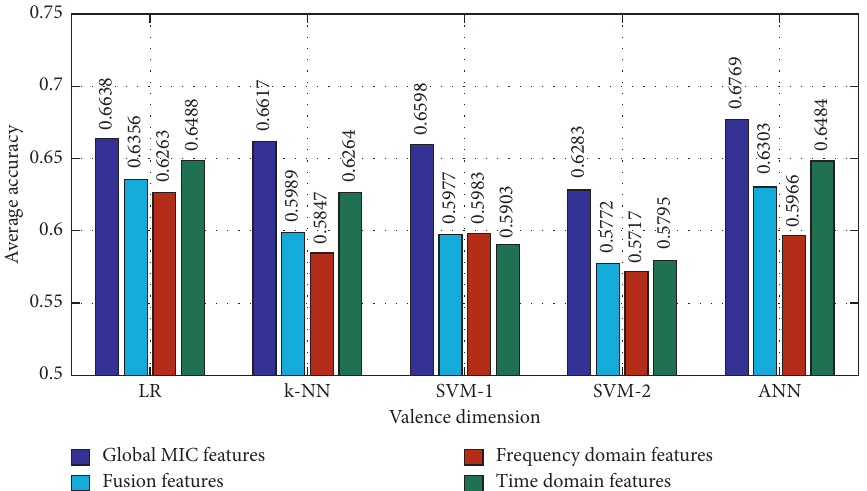
Figure 8: Average recognition accuracy of the four features in the valence dimension using different